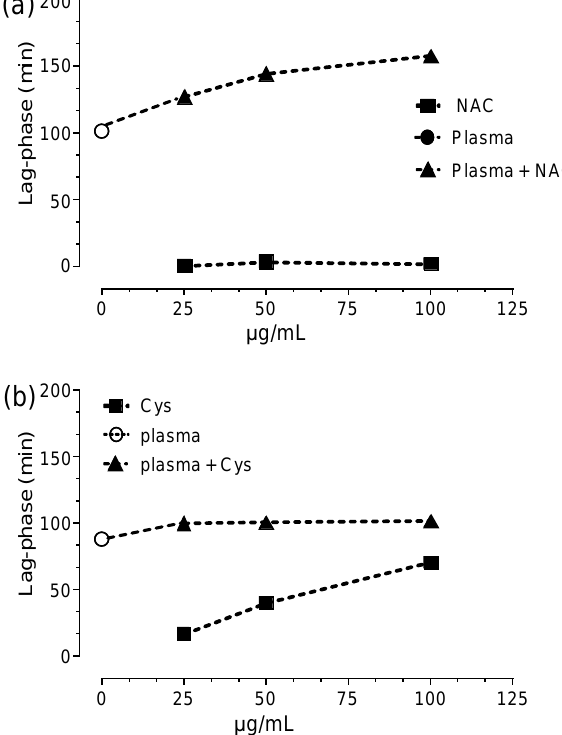
Figure 9. Dose-dependent lag-phase induced by NAC and Cys in absence and presence of plasma.